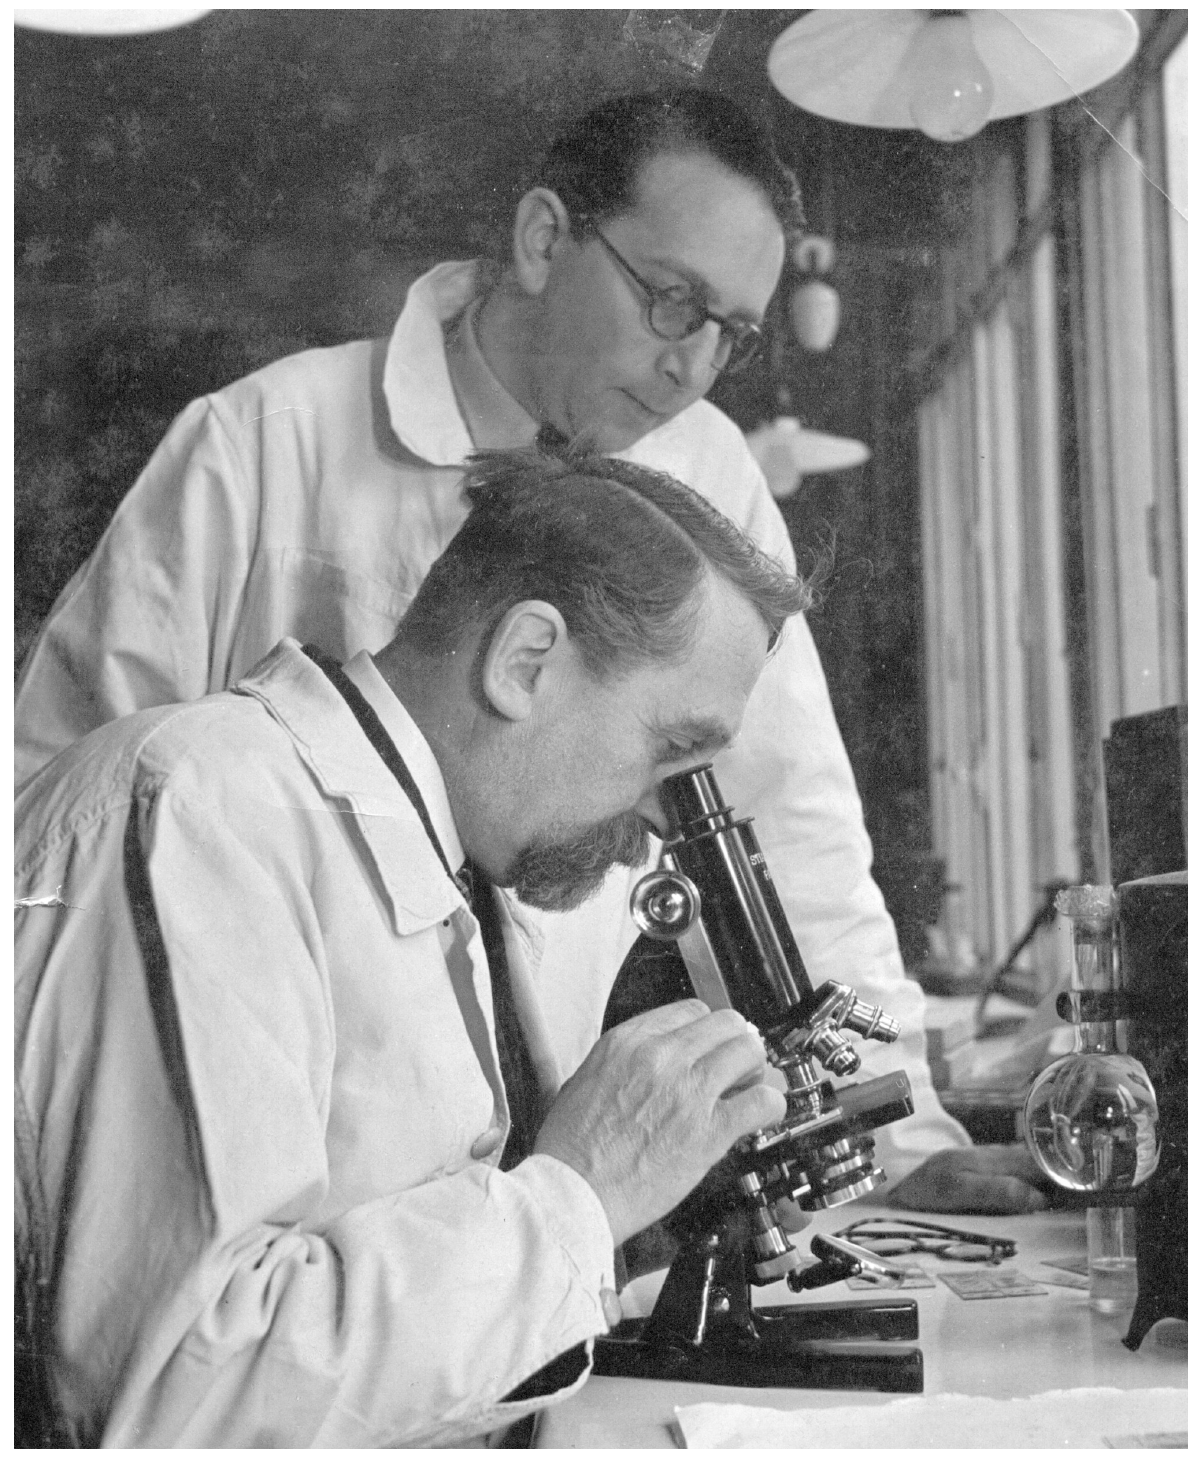
Fig 1. Cecilio Roma ñ a working with Emile Roubaud.